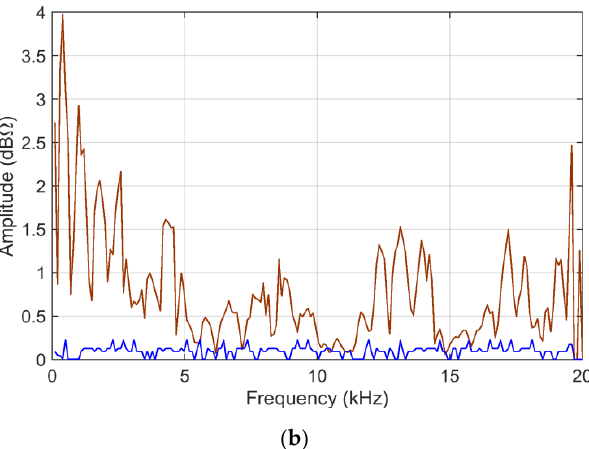
Figure 9. Z (47.5 km) and Z (48.0 km) input data in logarithmic scale: ( a ) ADM i and ( b ) FDM i sensitivity curves, comparing analytical first-order derivative calculation (blue) and normalized standard deviation of MCM output (brown).